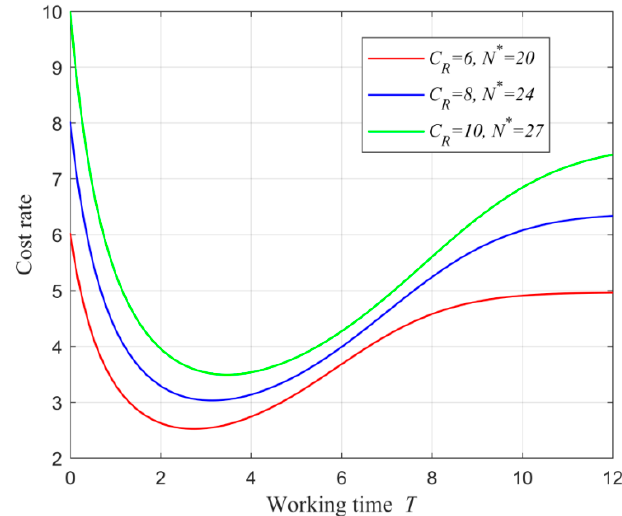
C on the optimal RNN. Figure 3. The impact of Figure 3. The impact of C R on the optimal R